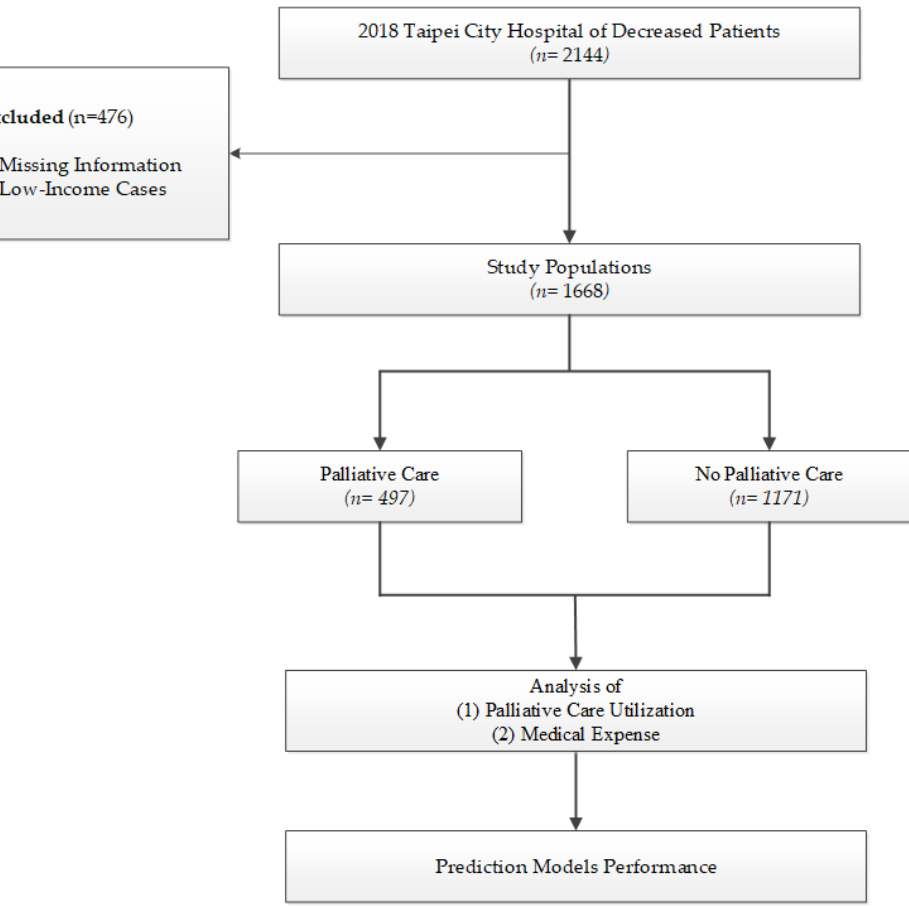
Figure 1. Research flow chart of patients deceased between 1 January 2018 and 31 December 2018.